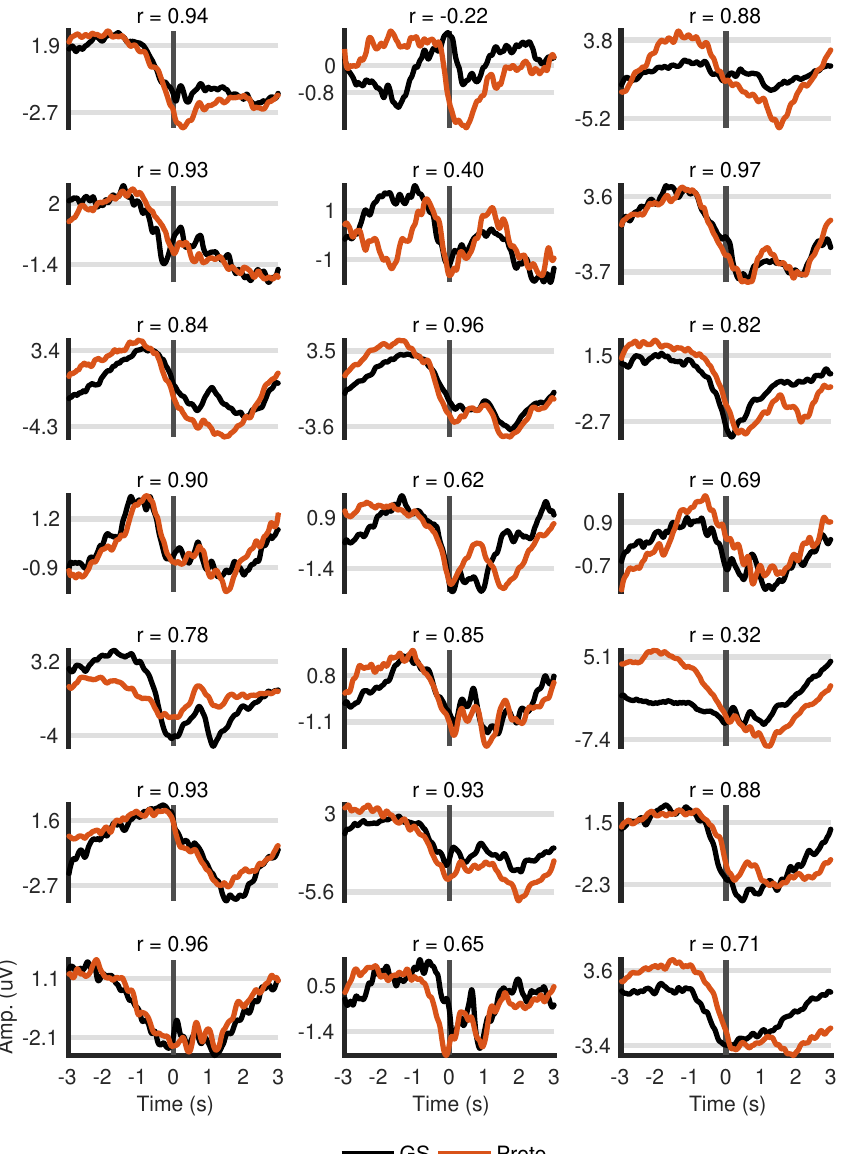
Figure A2. Averaged MRCPs for 21 participants in step on/off from gold standard and the prototype along with cosine similarity (r). GS and Proto stand for the gold standard and the prototype system